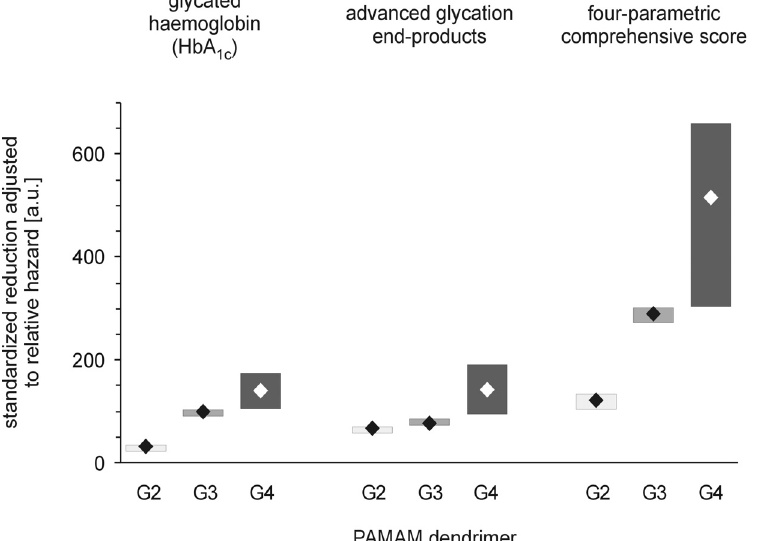
Figure 6. PAMAM dendrimer-induced reduction in markers of hyperglycaemia adjusted to overall mortality in streptozotocin-diabetic rats. The data, which are presented as median and interquartile range (lower 25% quartile to upper 75% quartile; n = 5–19), represent standardised reductions (per μ mol NH /kg body weight/day) in hyperglycaemia/oxidation 2 markers expressed in arbitrary units, a.u., after adjustment for overall mortality (relative hazard) in diabetic Sprague-Dawley rats treated intraperitoneally with PAMAM dendrimers. Relative hazard was estimated using the Kaplan-Meier method (for more details, see the text and the legends to Figures 2 and 5). The significance levels of the observed differences were: HbA , p < 0.01, G2 vs. G3, p < 0.04, G3 vs. G4, 1c adj hazard p < 0.001, G2 vs. G4; AGEs , p < 0.02, G2 vs. G3, p < 0.0001, G3 vs. G4, p < adj hazard